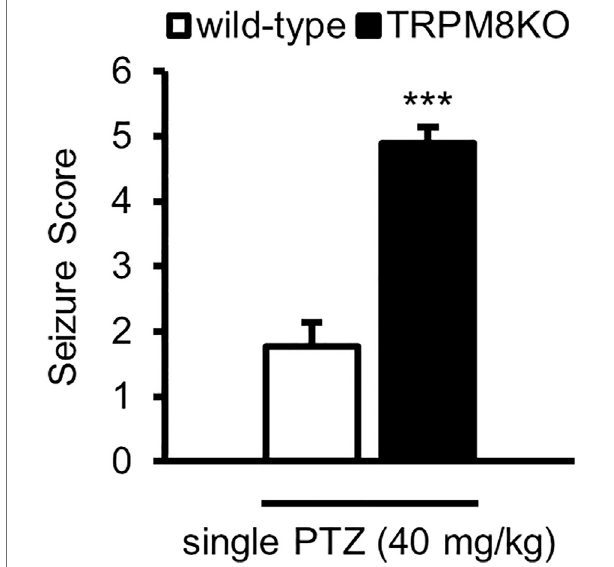
FIGURE 1 | Exacerbation of seizure score by lack of TRPM8 channels. Mean seizure scores for WT (white: n (cid:2) 6) and TRPM8KO (black: n (cid:2) 6) mice, which were at the maximum during 60 min. The results are shown as mean ± SEM;*** p < 0.001,Student ’ s t -test. TRPM8, transient receptor potential melastatin 8; PTZ, pentylenetetrazol; WT, wild type; SEM, standard error of the